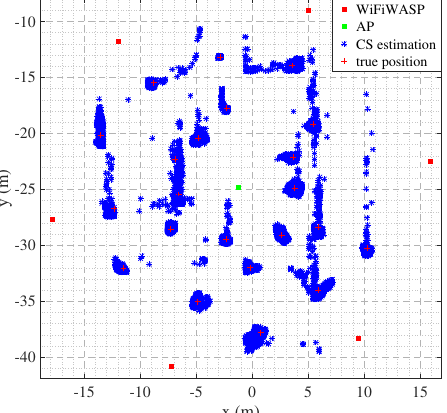
Figure 7. Positioning results in outdoor LOS